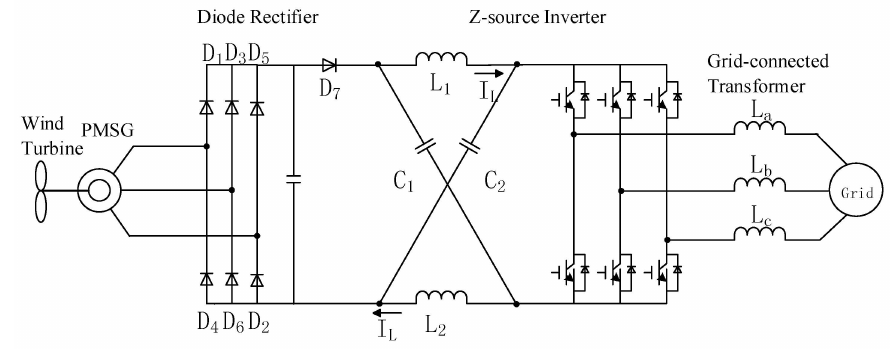
Figure 1. The topology of Z-source grid-connected wind generation system. PMSG: permanent-magnet synchronous